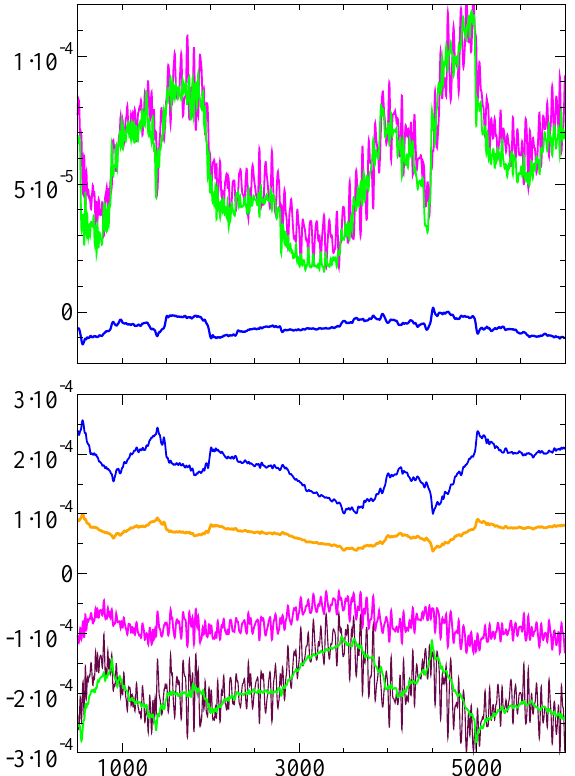
Fig. A1. For the same run as in Fig. 5 (middle) (i.e., β = 0 . 3 and d i /l f = 0 . 080), time evolution of the terms entering the r.h.s. of the equation for µ ⊥ and T ⊥ (top) and µ k and T k (bottom). The color code is blue for gyrotropic heat fluxes, and green for Hall effect in the µ equations; magenta for mechanical contributions, and orange for gyrotropic heat fluxes in the temperature equation. In the bot- tom panel, the maroon curve is the same as the magenta one after rescaling by a factor